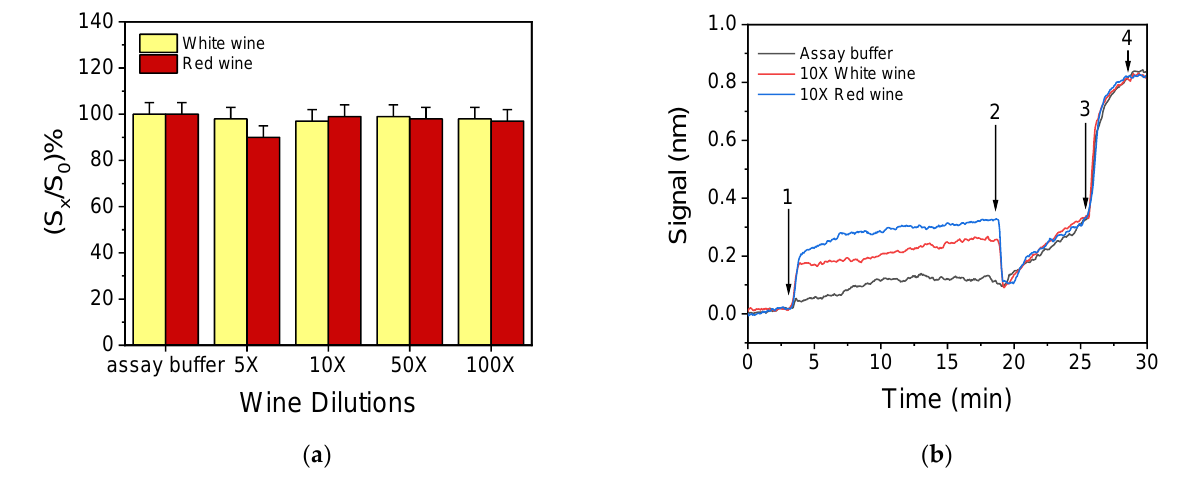
Figure 5. ( a ) Effect of white (yellow columns) and red wine (red columns) dilutions with assay buffer on the zero calibrator signal, with respect to signal in buffer. Each bar represents the mean value of three measurements ± SD. ( b ) Real-time responses obtained from a chip functionalized with OTA-OVA conjugate (200 µ g/mL) upon running: arrow 1 to 2, a mixture of zero calibrator prepared in assay buffer (black line) or 10-time diluted white wine (red line) or red wine (blue line) with 1 µ g/mL of rabbit anti-OTA Ab (1:1 v / v ); arrow 2 to 3, biotinylated secondary antibody; and arrow 3 to 4, streptavidin. Table 2. Percent recovery values of OTA spiked in cereal flours and white and red wine samples. Food